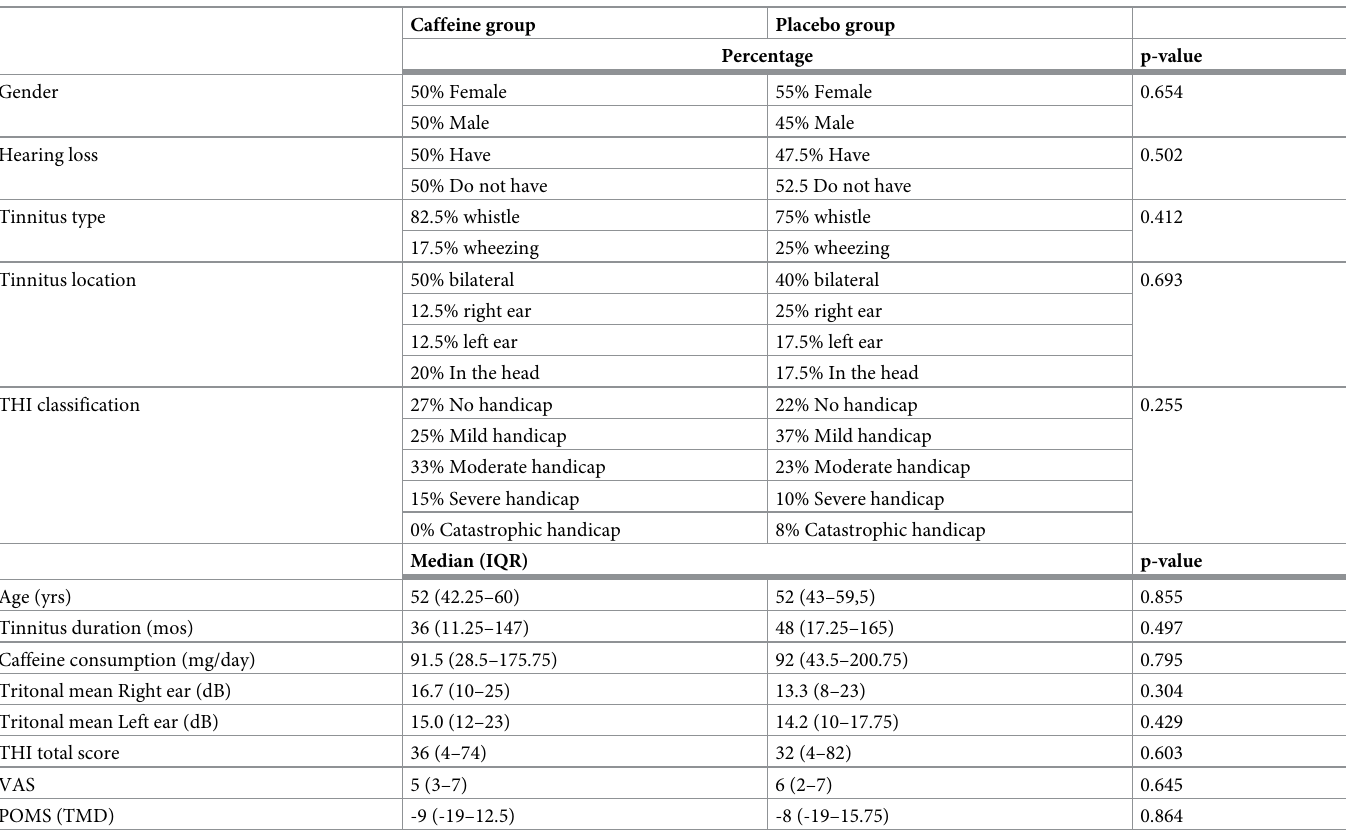
Table 2. Intergroup comparison of individual characteristics and